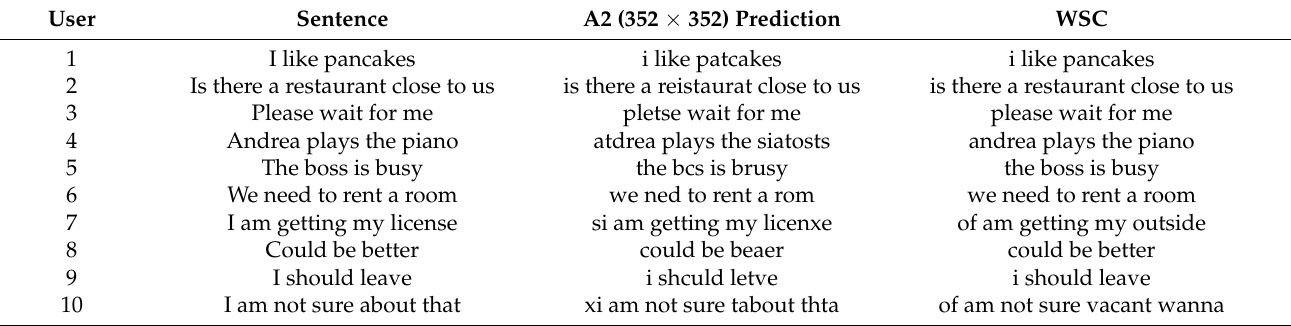
Table 4. American Sign Language alphabet translator (ASLAT) real-time results.